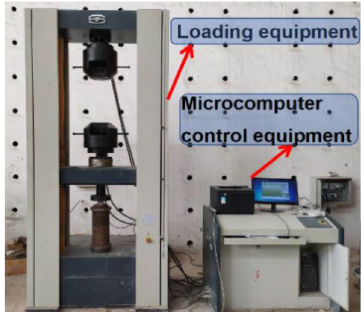
Figure 19. Microcomputer controlled testing machine.